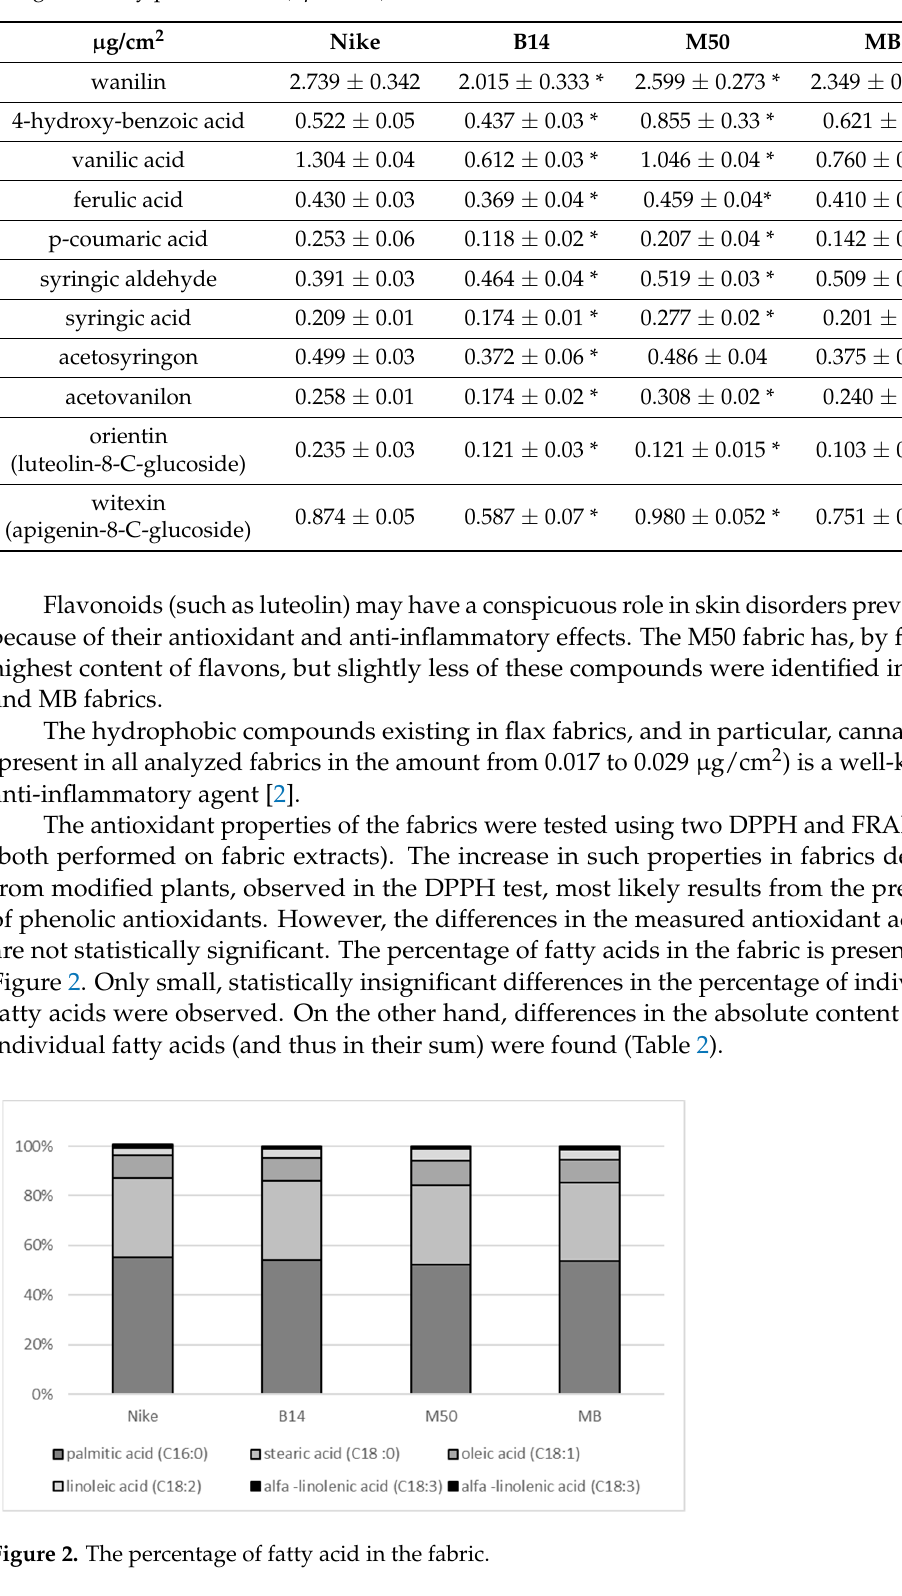
Table 1. Content of hydrophilic bioactive compounds per cm 2 of fabric—the measurement was made after the sterilization to also take into account any losses arising in this process (average of 5–6 independent samples obtained from different parts of the fabric). The statistical significance of the differences between the results for the tested linen fabrics compared to the control was calculated using the Tukey post hoc test (* p < 0.05).